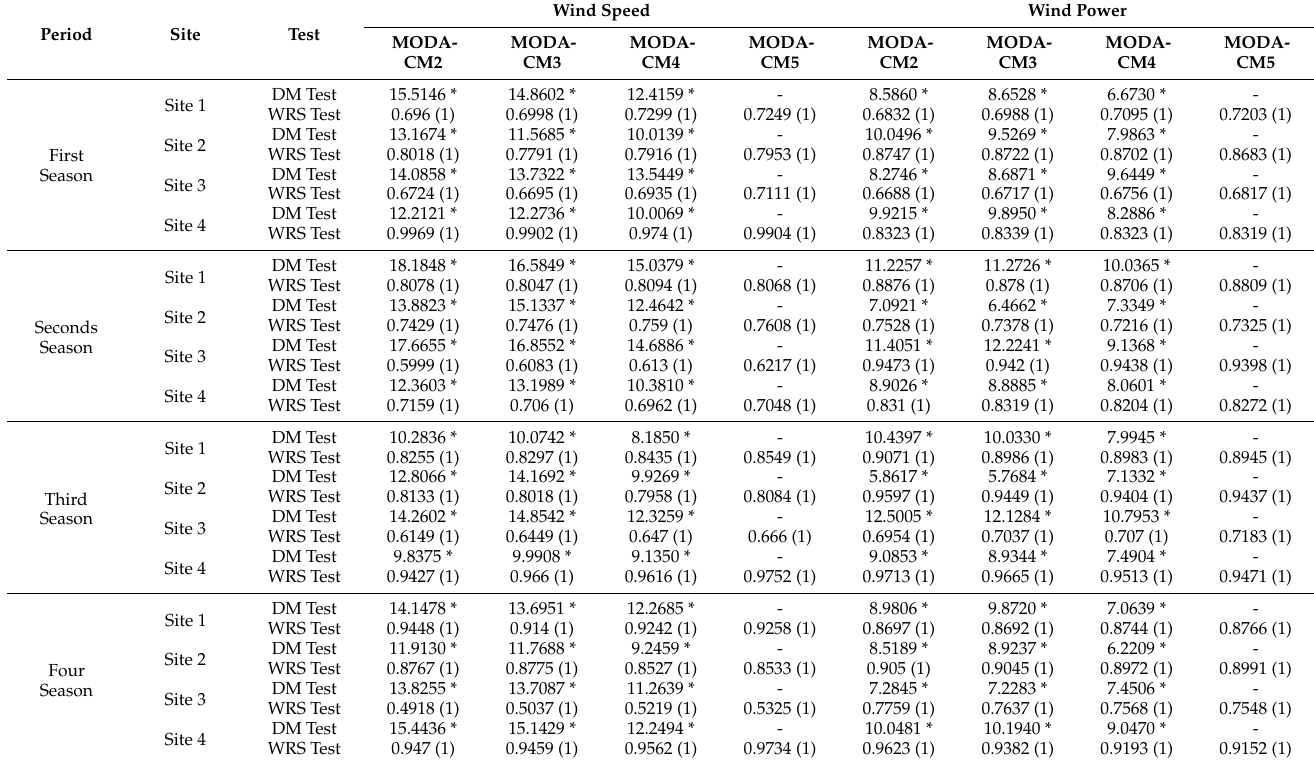
Table 8. The results of the DM test and WRS test for wind speed and wind power by each combined model.